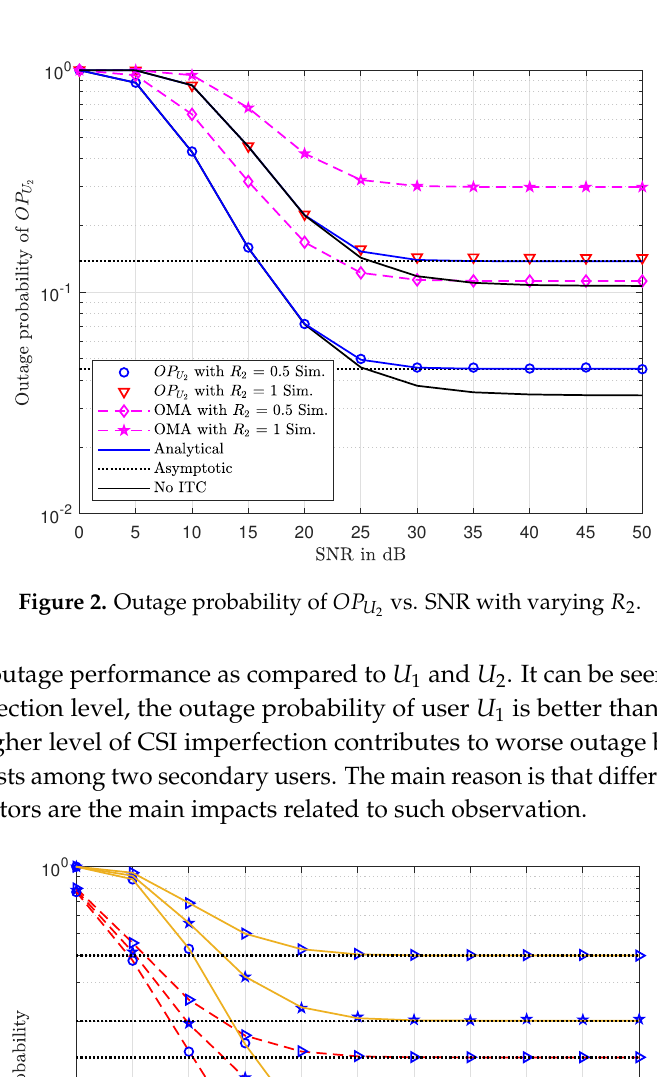
vs. SNR with varying R 2 . 2